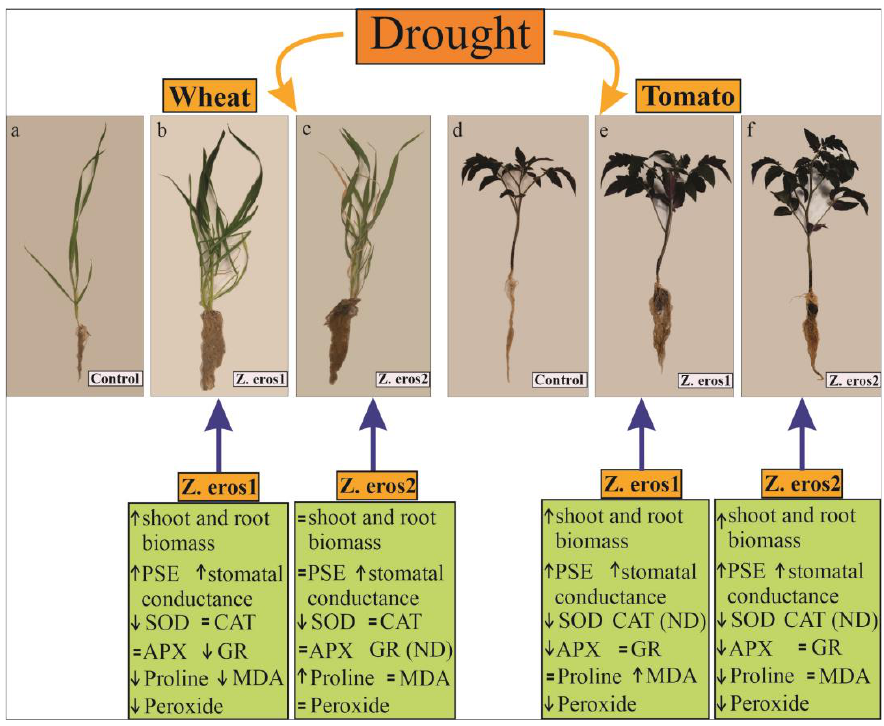
Figure 7. Effects triggered by two endophytic fungal strains ( Z. erostrata 1 and Z. erostrata 2) to alleviate drought stress in wheat and tomato plants. Wheat plants ( a – c ) and tomato plants ( d – f ), uninoculated controls and plants inoculated with the fungal endophytes Z. erostrata 1 y Z. erostrata 2 subjected to drought stress conditions. ↑ arrows show an increase, while ↓ arrows show a decrease in the variable. The sign = indicates no significant changes in the parameter, and ND: indicates not